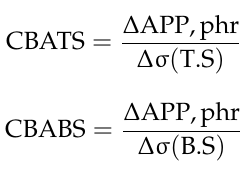
Figure 11. Relationship with CBABS by increasing the amount of modified flame retardant added.